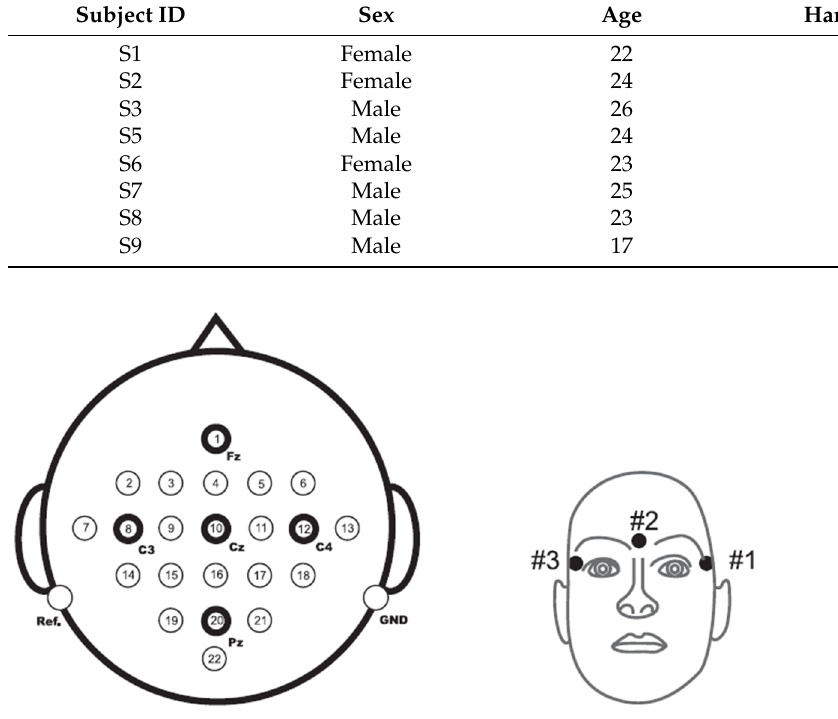
Figure 2. Distribution of EEG electrodes using the 10–20 system on the left and insertion of three monopolar EOG electrodes on the right [40].